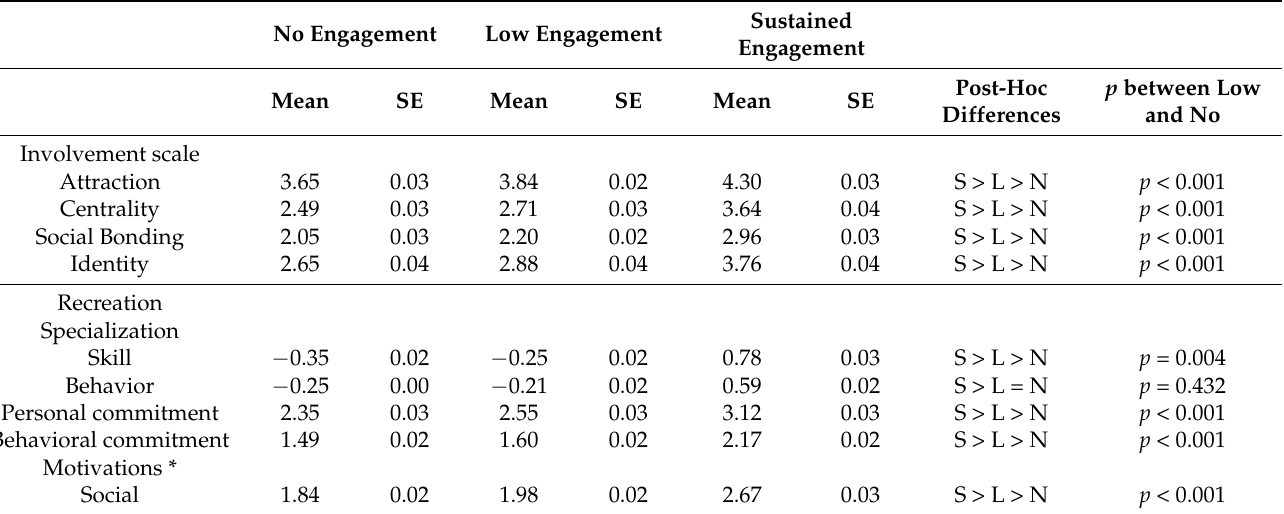
Table 3. Means (estimated from the linear model) of the three engagement clusters according to the different scales of specialization, involvement, and motivations. S = sustained engagement, L = low engagement, N = no engagement. p values between low and sustained engagement were all p <